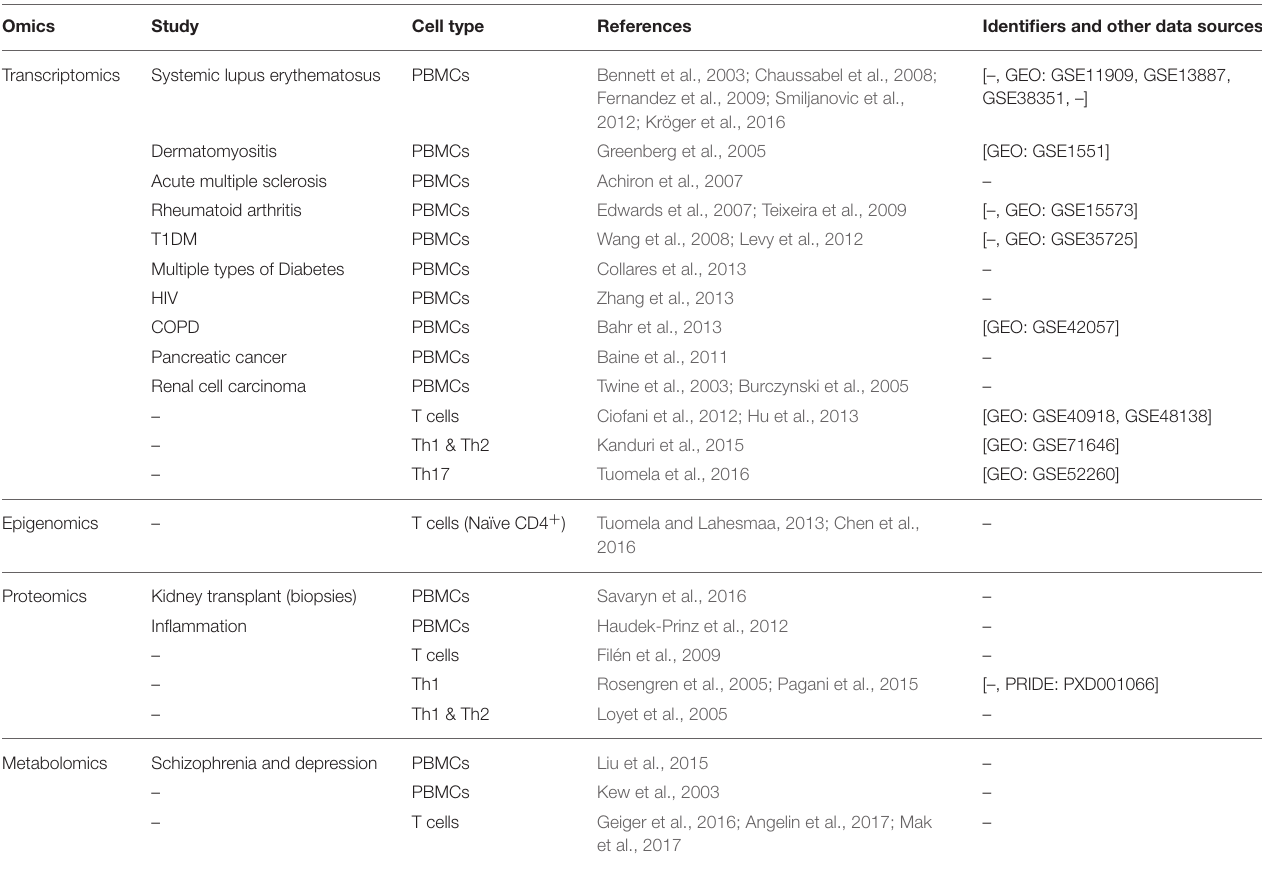
TABLE 1 | List of studies performed by using PBMCs and T cells as model systems.